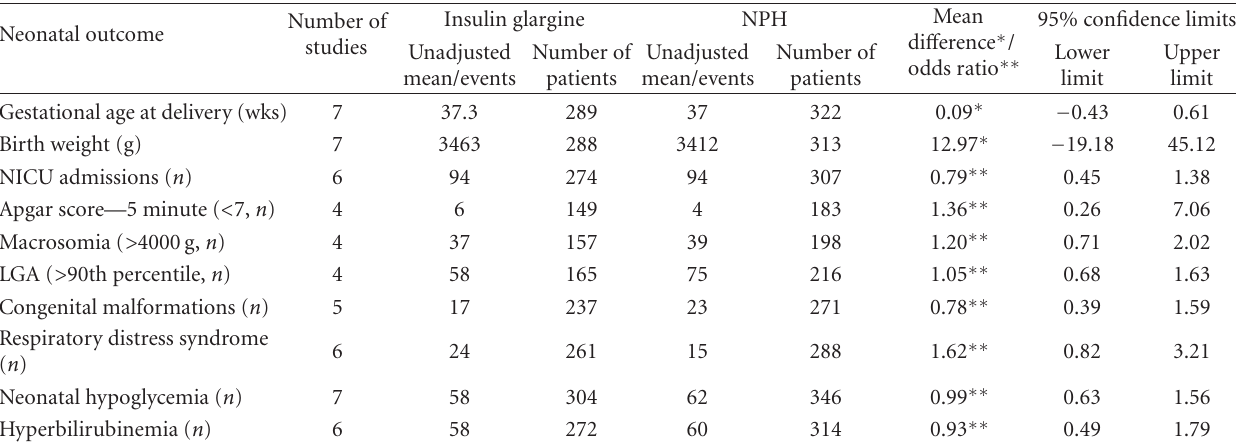
Table 4: Neonatal outcomes of pregnant women using insulin glargine versus NPH among the studies selected for meta-analysis. Number Neonatal outcome